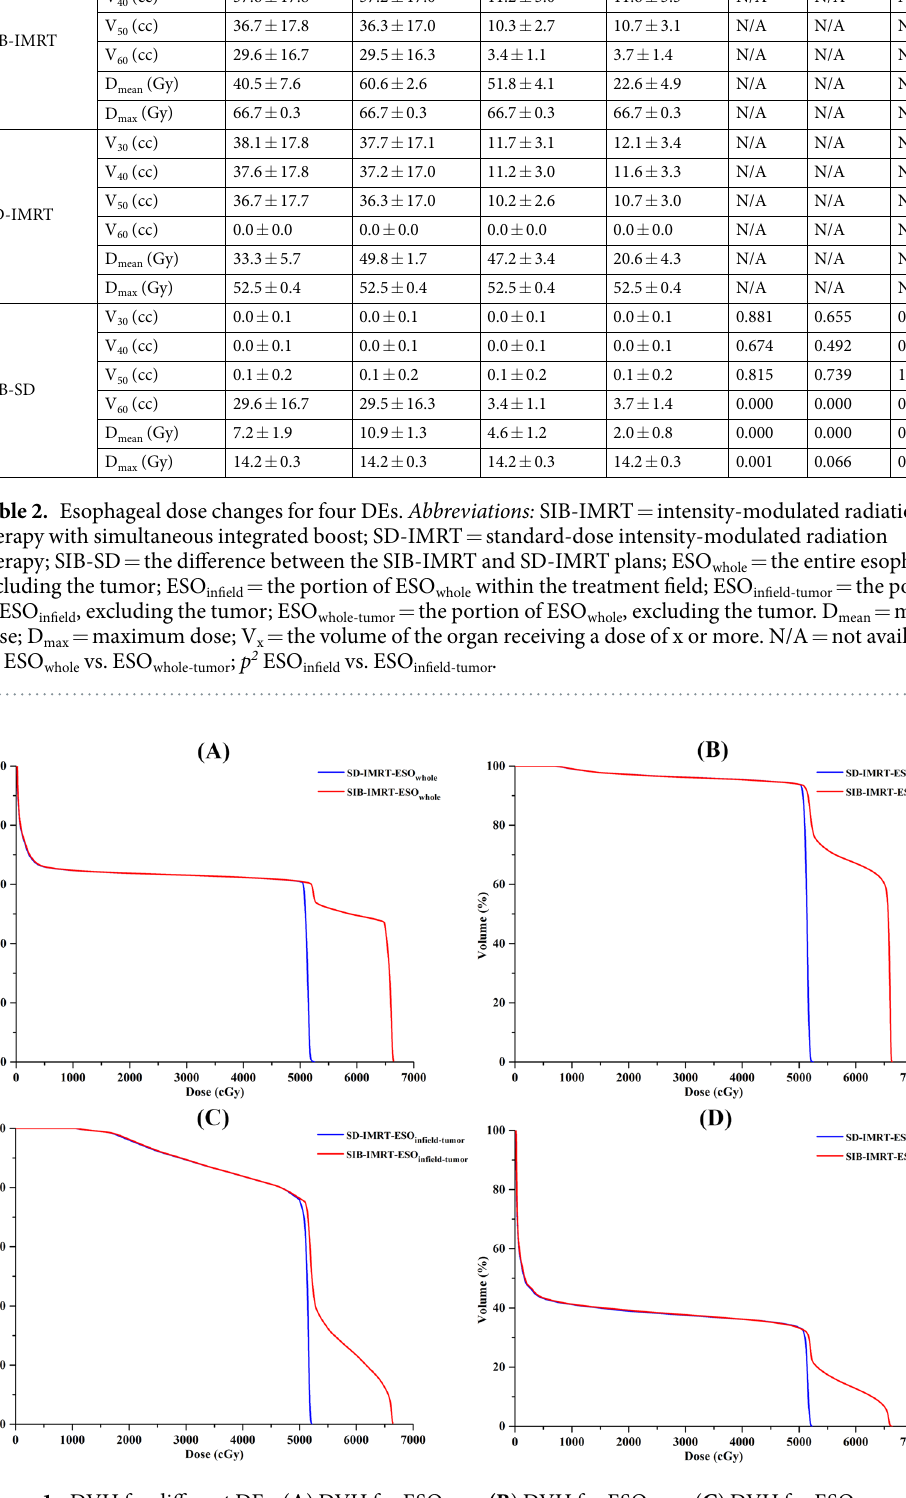
Figure 1. DVH for different DEs. ( A ) DVH for ESO whole , (B ) DVH for ESO infield , ( C ) DVH for ESO infield-tumor and ( D ) DVH for ESO whole-tumor . ESO whole = the entire esophagus including the tumor; ESO infield = the portion of ESO whole within the treatment field; ESO infield-tumor = the portion of ESO infield , excluding the tumor; ESO whole-tumor = the portion of ESO whole , excluding the tumor. SIB-IMRT = intensity-modulated radiation therapy with simultaneous integrated boost; SD-IMRT = standard-dose intensity-modulated radiation